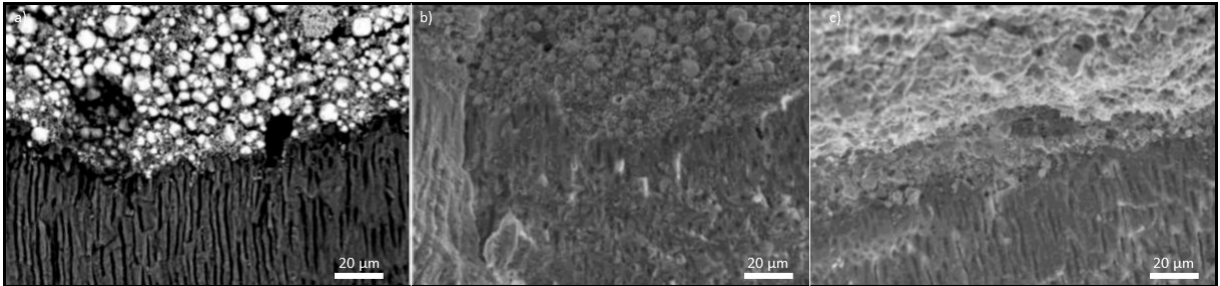
Figure 12. Fine particles of the sealant in the view of the longitudinal course of the dentinal tubules and the boundary with the tight connection of the sealant with the root canal wall: ( a ) thermoplastically condensed gutta-percha material, viewed with SEM–backscatter electron detector (BSD); ( b , c ) gutta-percha-based material thermoplastically condensed with the THC method, viewed with SEM.